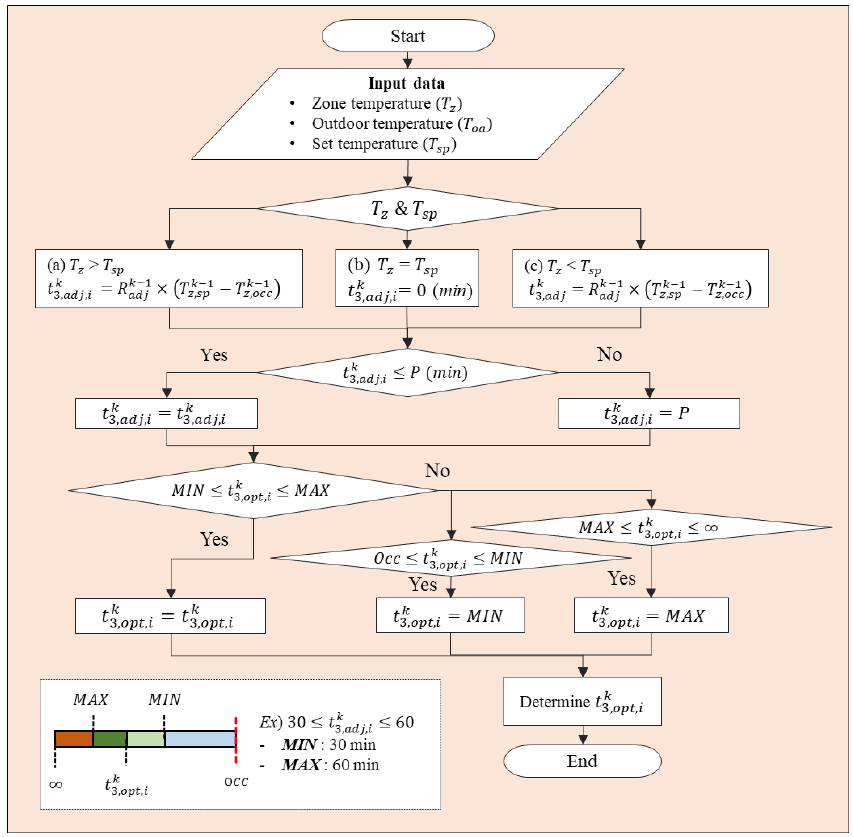
Figure 1. Optimal control strategy and rules.